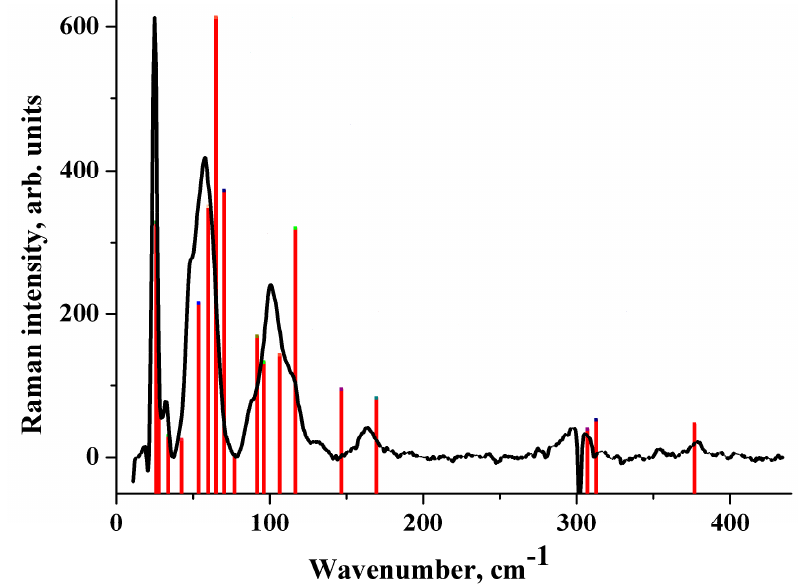
Figure 3. Raman spectrum of [CRB + MLE] (1:1). Experiment (black line) vs. B3LYP(AtomOnly) computations (red bars). The height of the bars is proportional to the relative Raman intensity of the corresponding transition.